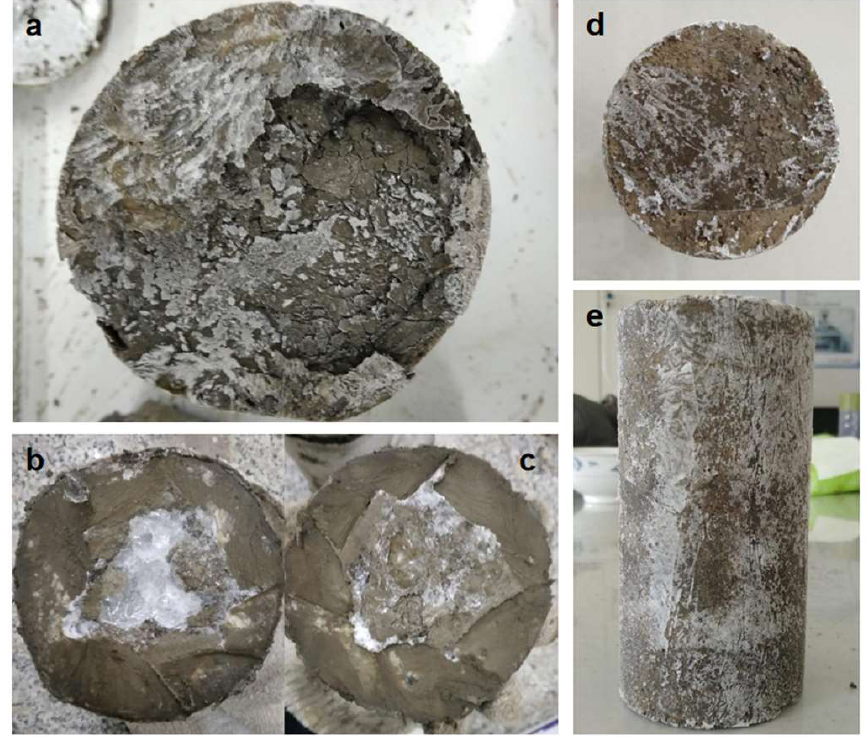
Figure 1. Photos of ( a ) the external surface section of undisturbed silty clay island permafrost; ( b , c ) the internal cross-section of undisturbed silty clay island permafrost; and ( d , e ) the external surface of remolded frozen soil.